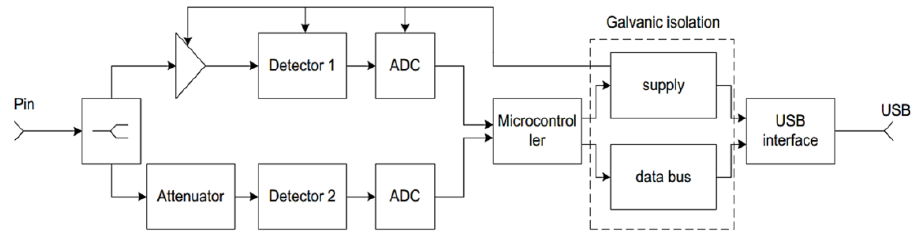
Fig. 4. PLS06 block